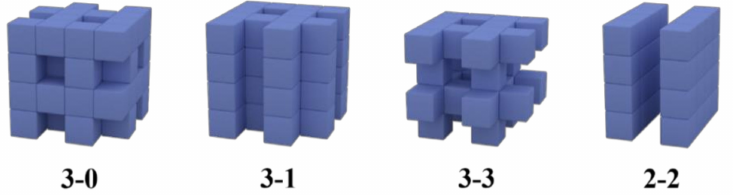
Figure 1. Schematic showing the potential connectivity of the porous ceramics, the first number denotes the connectivity of the ceramic phase, while the second number denotes the connectivity of the pore